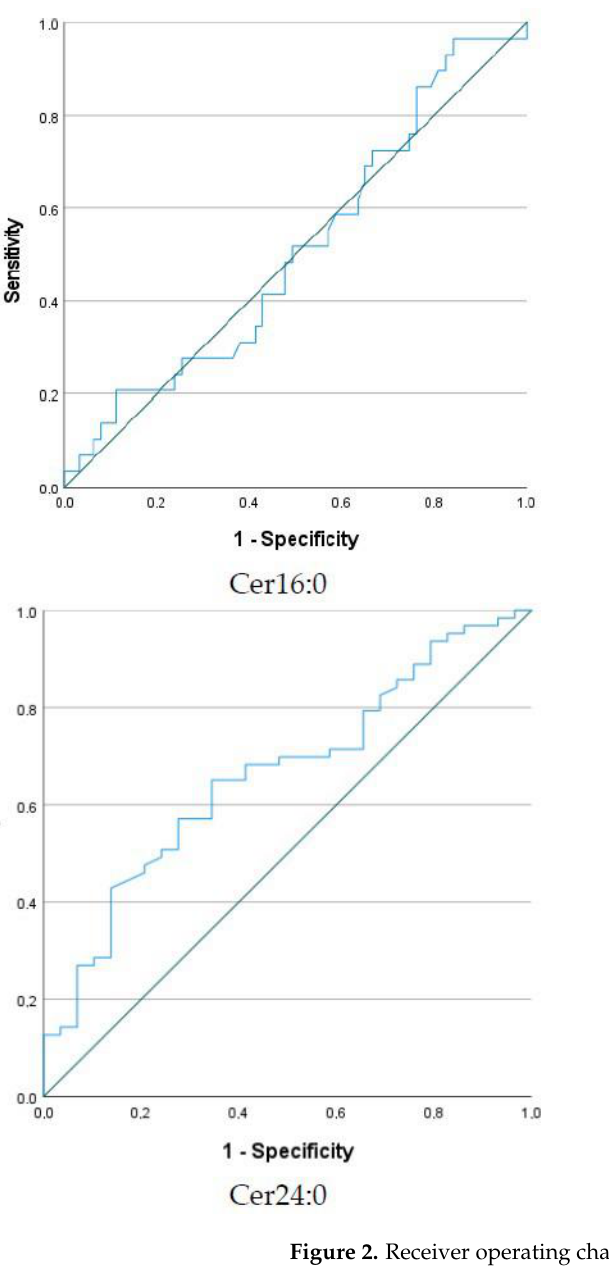
Table 3. Correlation among ceramide concentrations and studied parameters for all studied women (GDM and control